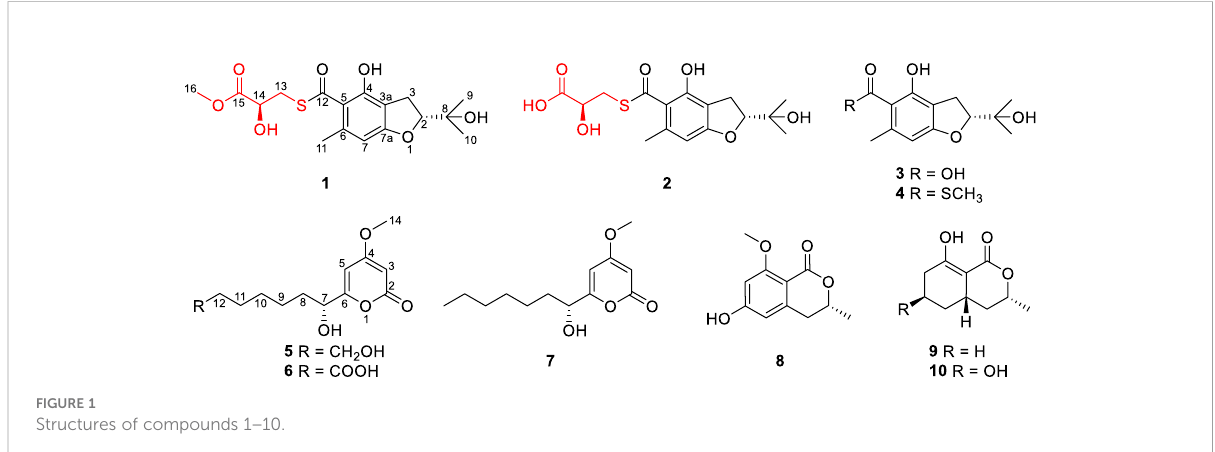
FIGURE 1 Structures of compounds 1 −